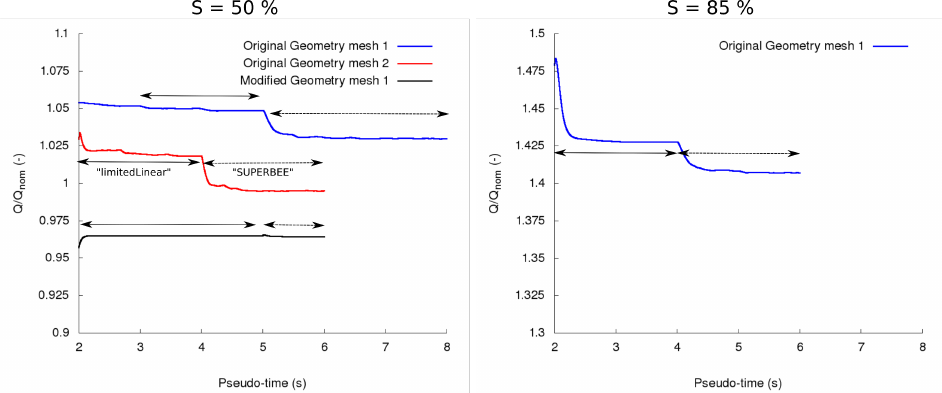
Figure 6. History of the discharge for each simulation. The period over which a specific limiter is used is highlighted by arrows.